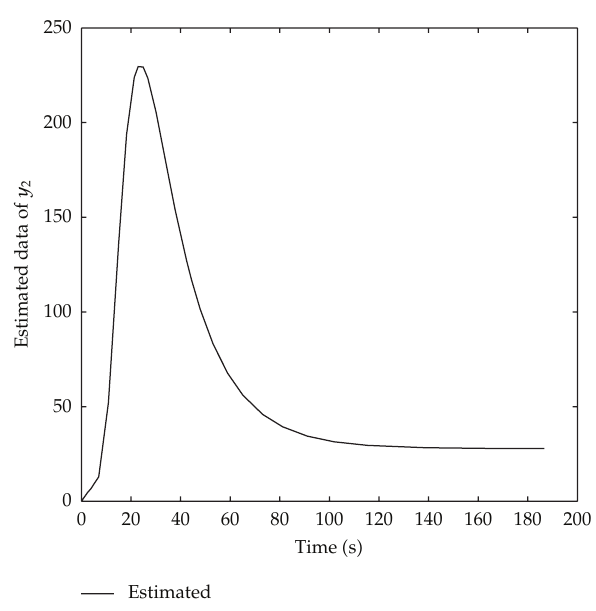
Figure 5: The plots of the estimated data of y 2 in Case 1 (cid:3) 149 iterations (cid:4) .